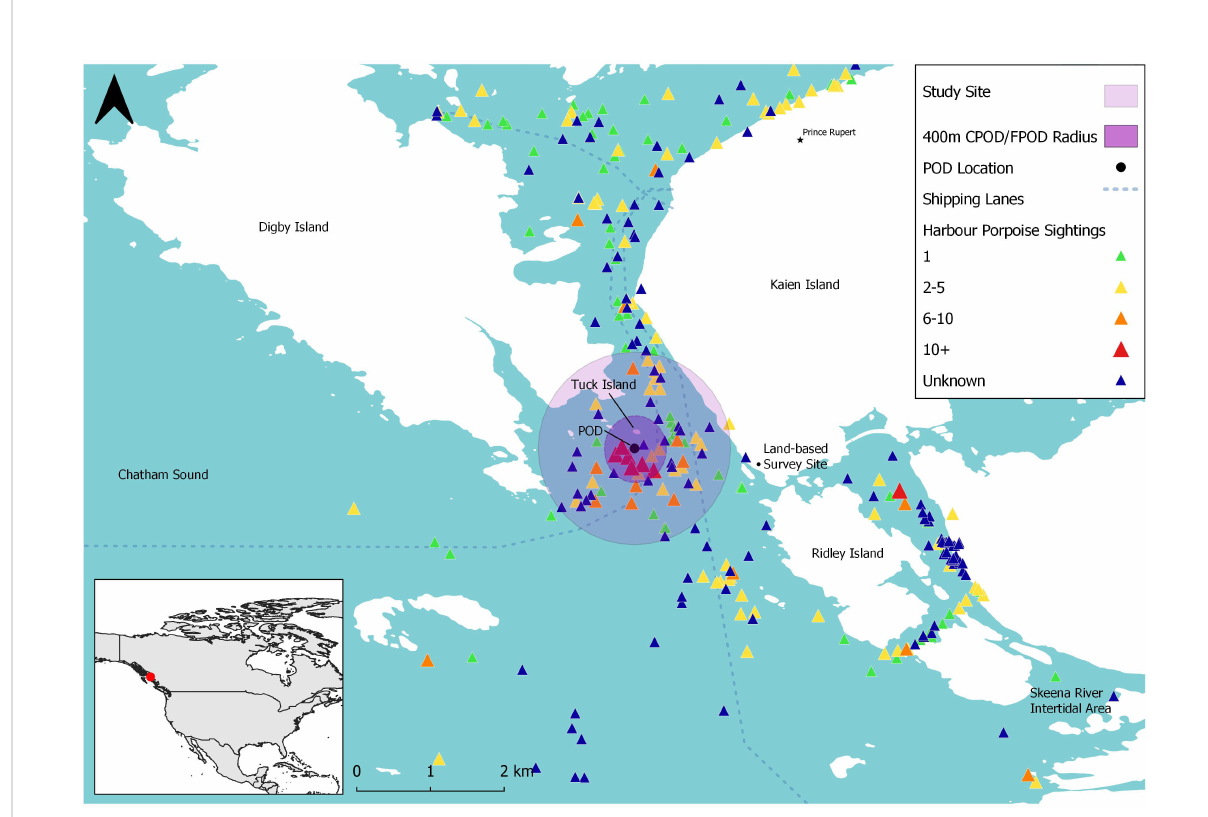
FIGURE 1 Map of study site (purple circle) south of Digby Island (British Columbia, Canada) and harbour porpoise sightings (triangles) reported to the British Columbia Cetacean Sightings Network (BCCSN) between 2016 and 2021. The black circle indicates the location of the Passive Acoustic Monitoring (PAM) device (C-POD/F-POD) found at the centre of the study site. The primary shipping lanes are represented by the dotted lines. Map in bottom left shows the larger map area (within purple box) in relation to North America. BCCSN sightings were fi ltered to contain only harbour porpoise sightings with ‘ Certain ’ and ‘ Probable ’ con fi dence levels (n =